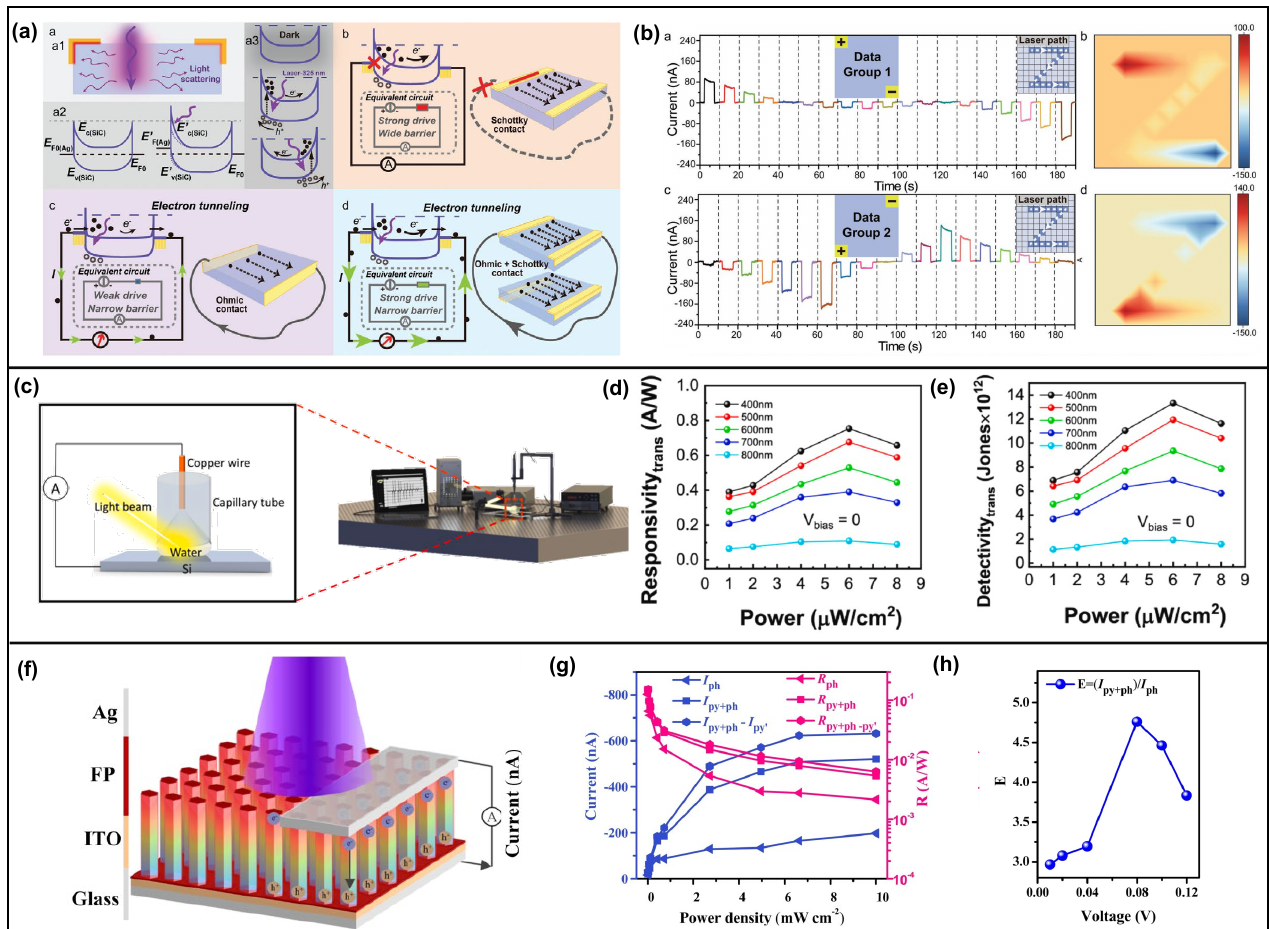
Figure 11. ( a , b ) Working mechanism and application of the self-powered 4H-SiC photodetector. Reproduced with permission from [87]. Copyright 2022 Wiley; ( c ) Schematic of the pyroelectric photodetector characterization setup; ( d , e ) The responsivity and detectivity of the Si/water device under different light wavelengths as a function of light intensity at zero bias. Reproduced with permission from [88]. Copyright 2022 Elsevier; ( f ) Schematic illustration of self-powered fibrous phosphorus/Ag Schottky junction photodetector; ( g ) I py + ph , I ph , and I py + ph − I py’ and R py + ph , R ph , and R py + ph − py’ of self-powered photodetectors as a function of power density; ( h ) Corresponding enhancement factor E = (I py + ph )/I ph of self-powered photodetector as a function of bias voltage. Reproduced with permission from [90]. Copyright 2023 Wiley.